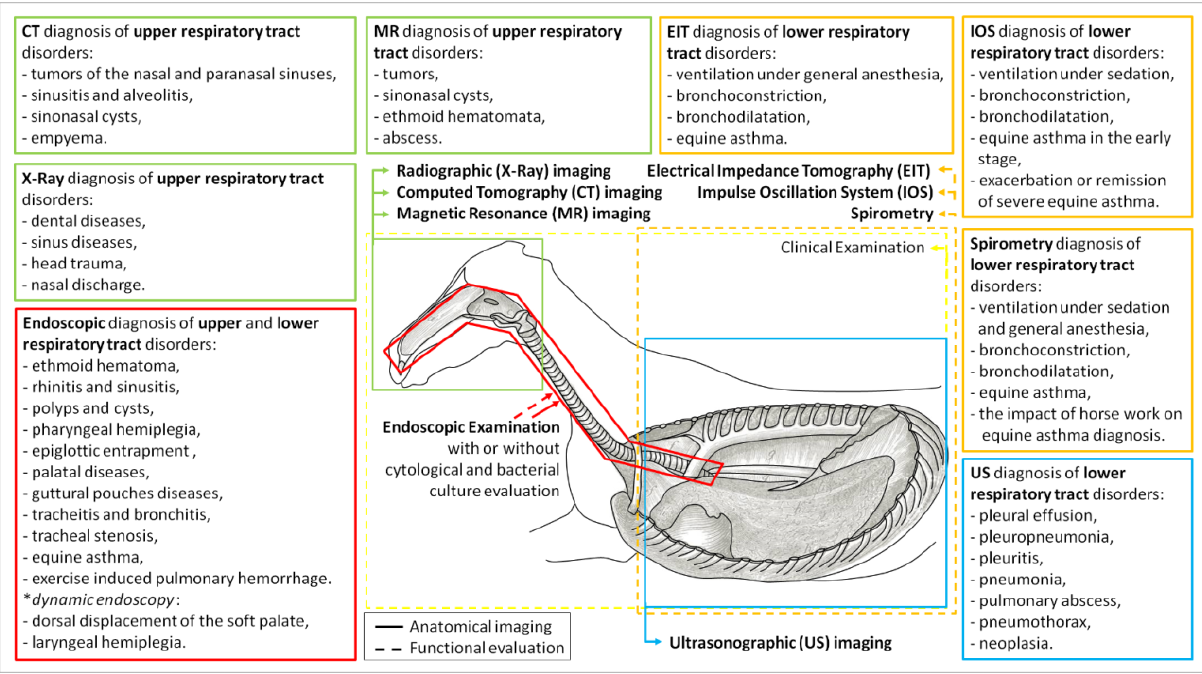
Figure 1. Application of the basic and advanced diagnostic techniques for the anatomical imaging and/or functional evaluation of the areas of the equine respiratory tract. CT—computed tomography; MR—magnetic resonance imaging; EIT—electrical impedance tomography; IOS—impulse oscillation system; X-ray—radiographic imaging; US—ultrasonographic